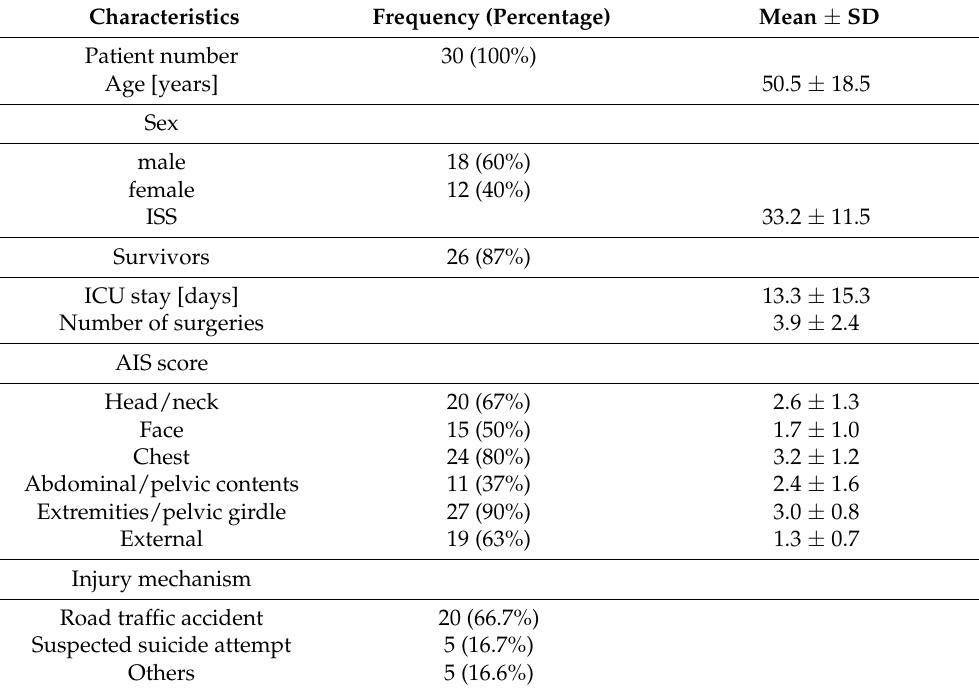
Table 1. Demographic patient